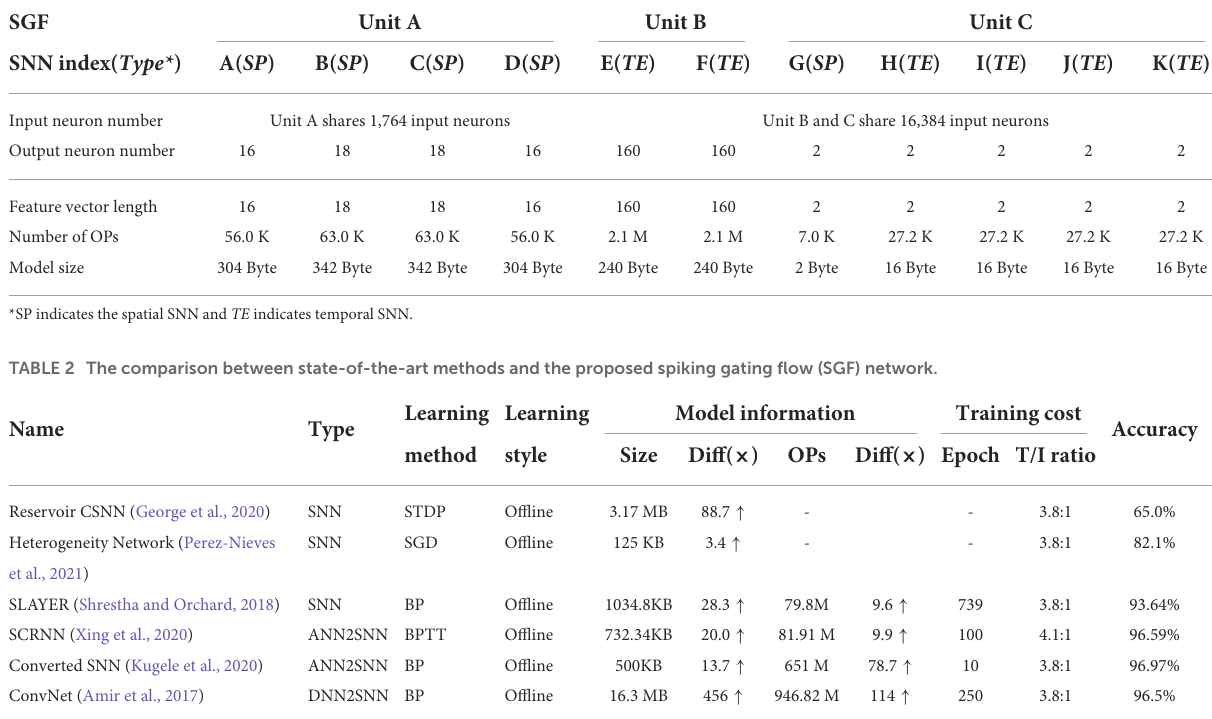
TABLE 1 The developed network architecture information.